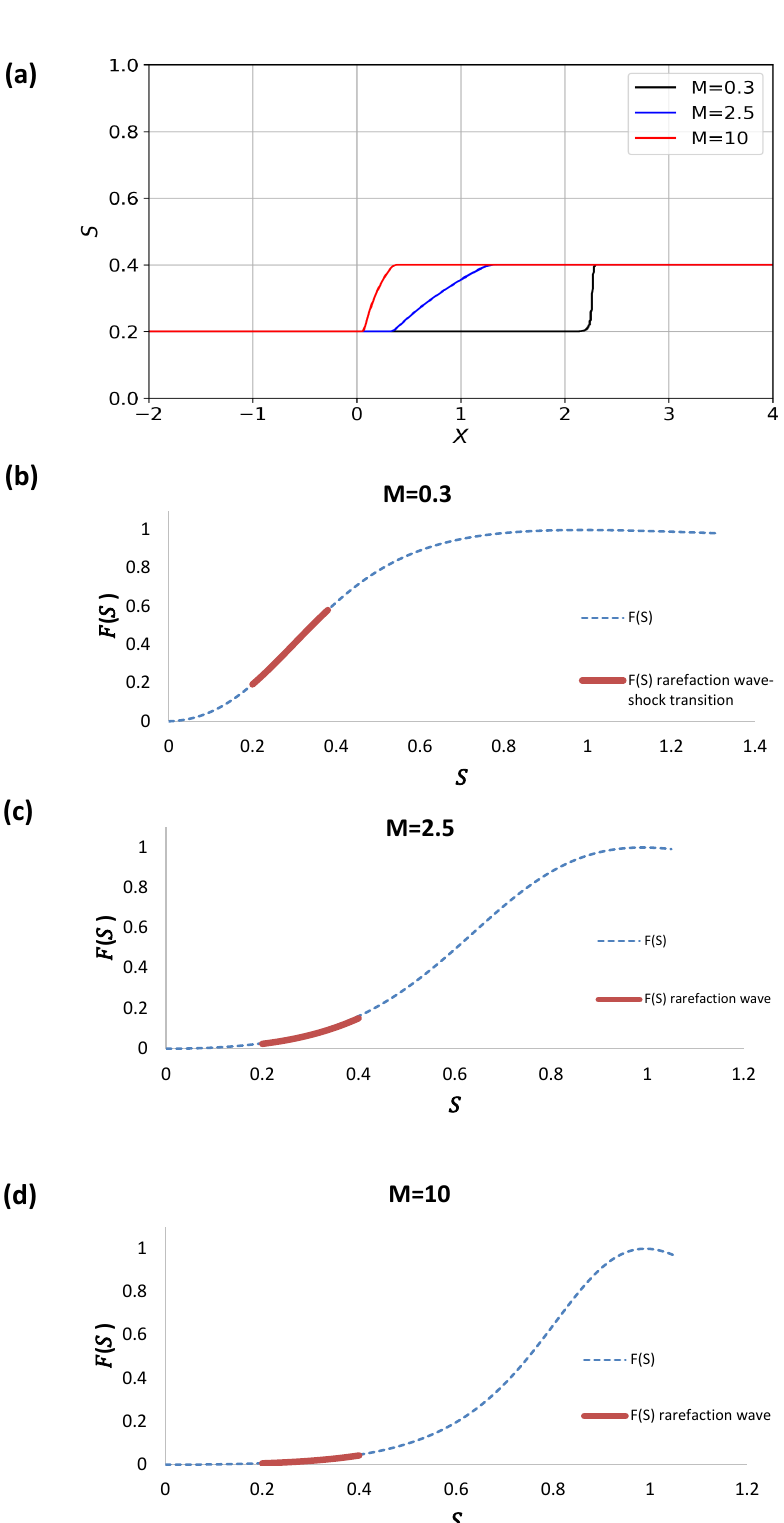
Figure 11. ( a ) Rarefaction wave solution for S l = 0.2, S r = 0.4, τ = 1, and ε = 0.01. The corresponding flux functions for three different mobility ratios ( b ) M = 0.3, ( c ) M = 2.5, and ( d ) M =